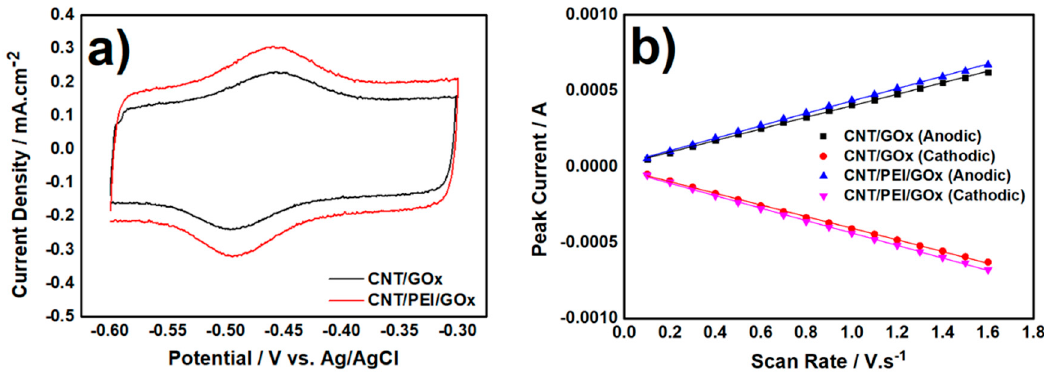
Figure 2. ( a ) CV curves of CNT/GOx and CNT/PEI/GOx at scan rate 100 mV · s − 1 . Linear trend between peak current vs. scan rate ranging from 100 to 1600 mV · s − 1 ( b ). All experiments were conducted under anaerobic condition by feeding N 2 gas at 100 mL · min − 1 and 0.1 M Phosphate Buffer Saline (PBS) pH 7.4 acted as the electrolyte.